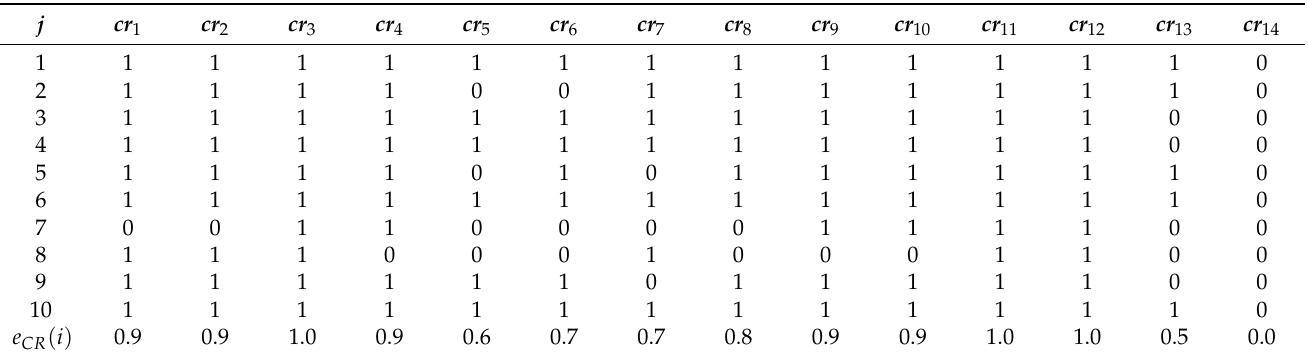
Table 6. A matrix of binary evaluation of cr i criteria, in the case of questionnaires filled out by J